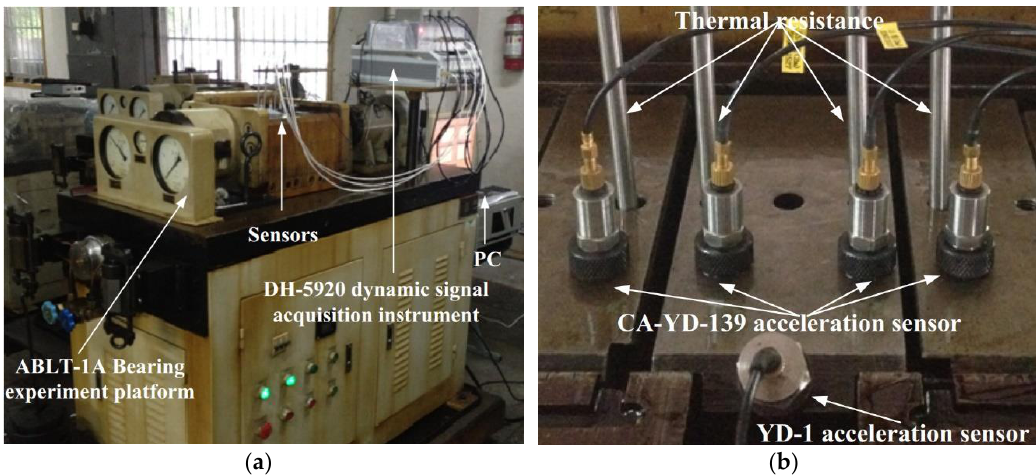
Figure A3. (a) The experimental rig and (b) the sensors layout of Hangzhou Bearing Test and Figure A3. ( a ) The experimental rig and ( b ) the sensors layout of Hangzhou Bearing Test and Research Center. Research